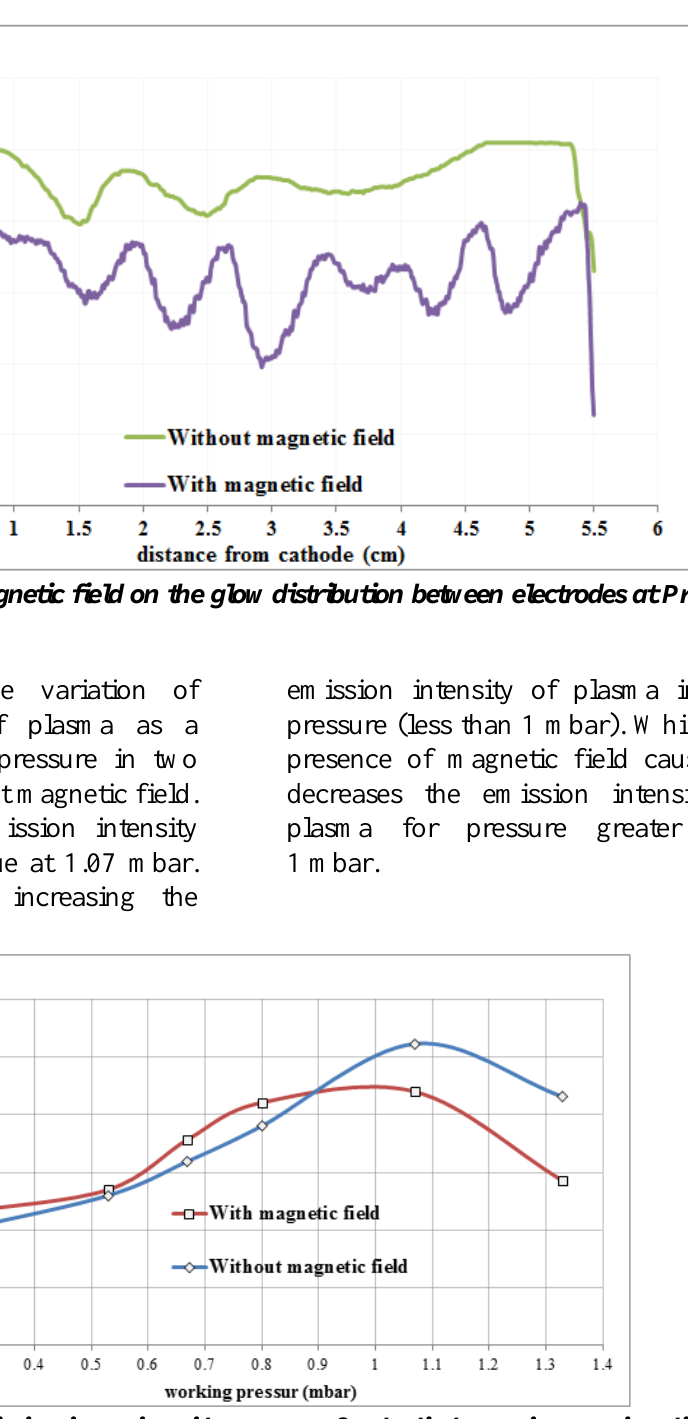
Fig. 9: Variation of emission intensity with pressure for dc discharge in Ar using different hollow cathode dimensions with and without